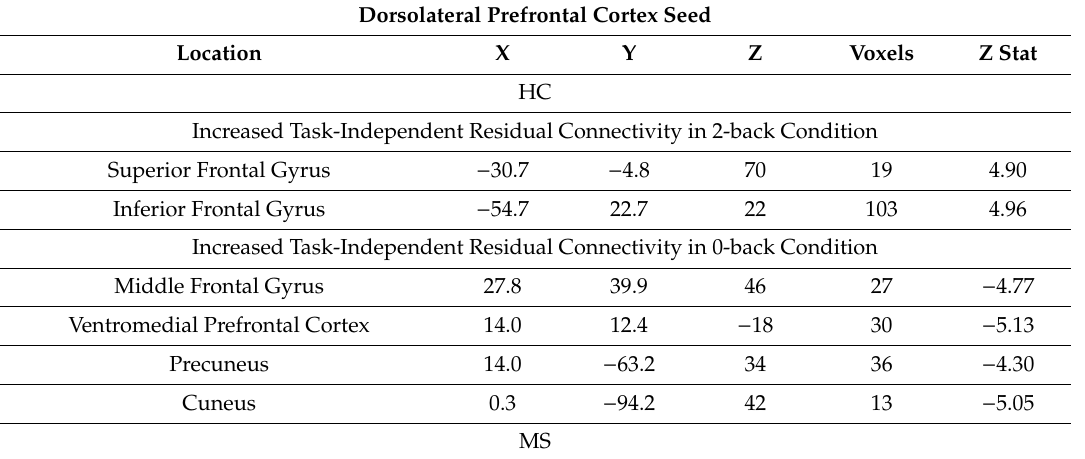
Table 3. Task-independent (residual) fatigue-related functional connectivity with the dorsolateral prefrontal cortex as